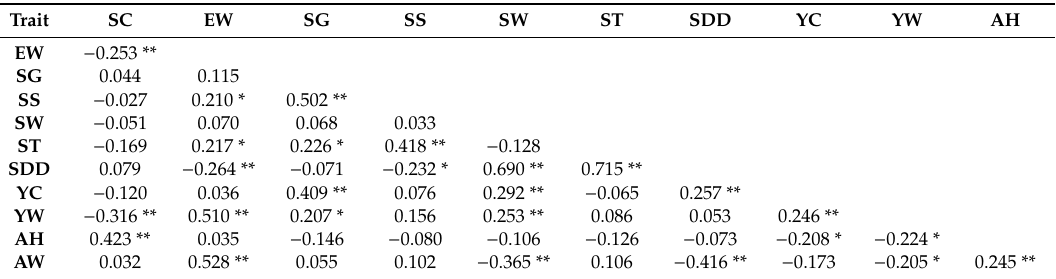
Table 2. Relations (Spearman’s correlation coe ffi cients) between measurable traits of Japanese quail table eggs. Trait